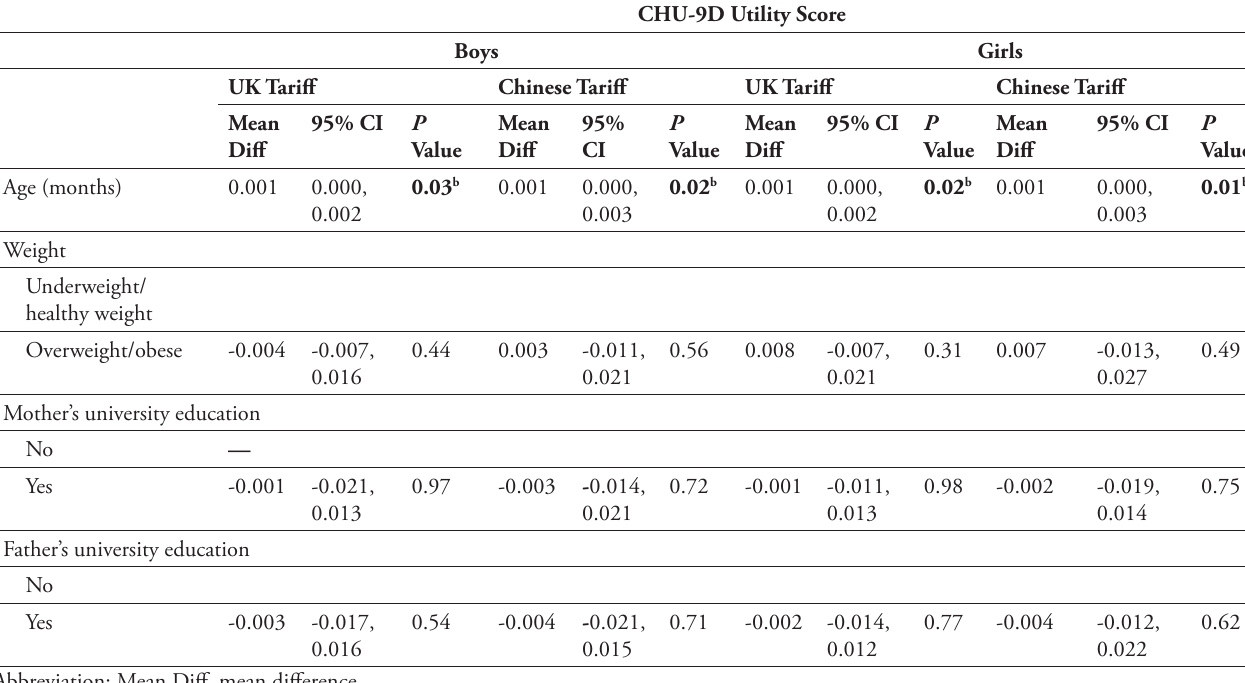
Table 5. Linear Mixed Regression Model Exploring Association Between Weight Category and HRQOL by Gender